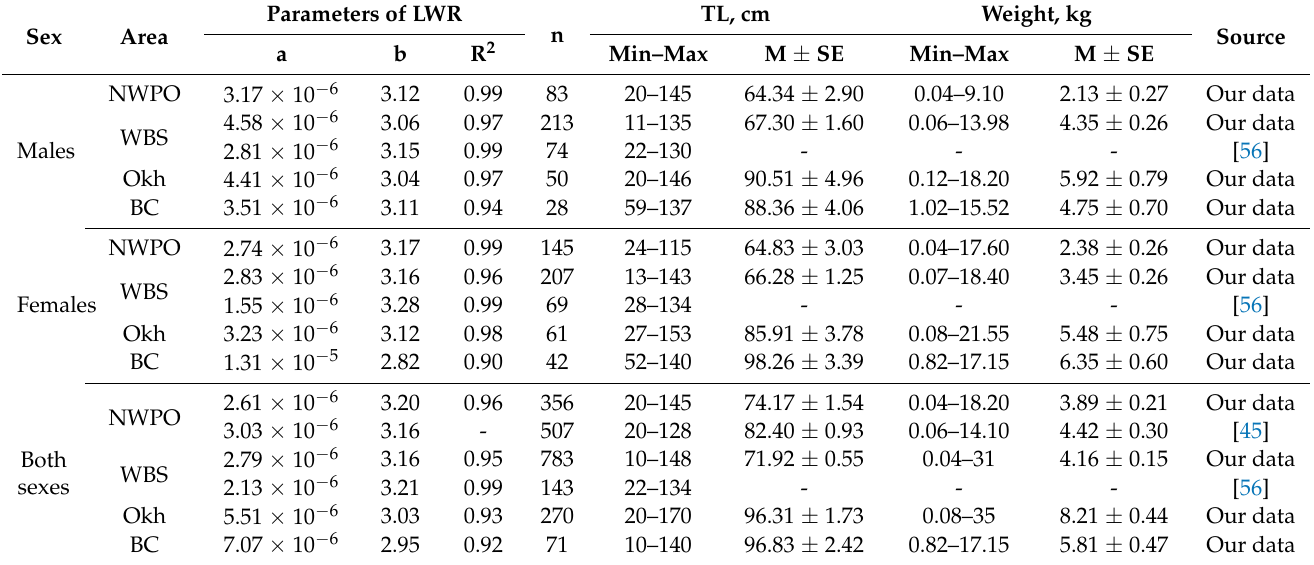
Table 2. Parameters of length–weight relationships (LWR) of the Aleutian skate Bathyraja aleutica by regions within its range (NWPO—the northwestern Pacific Ocean, WBS—the western Bering